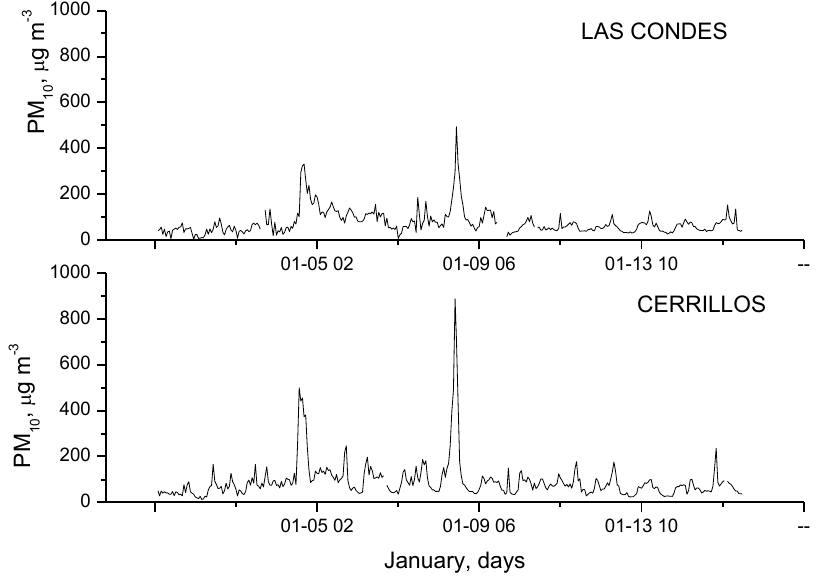
Figure 5. PM 10 time profile measured in Cerrillos and las Condes from 1–14 January 2014.